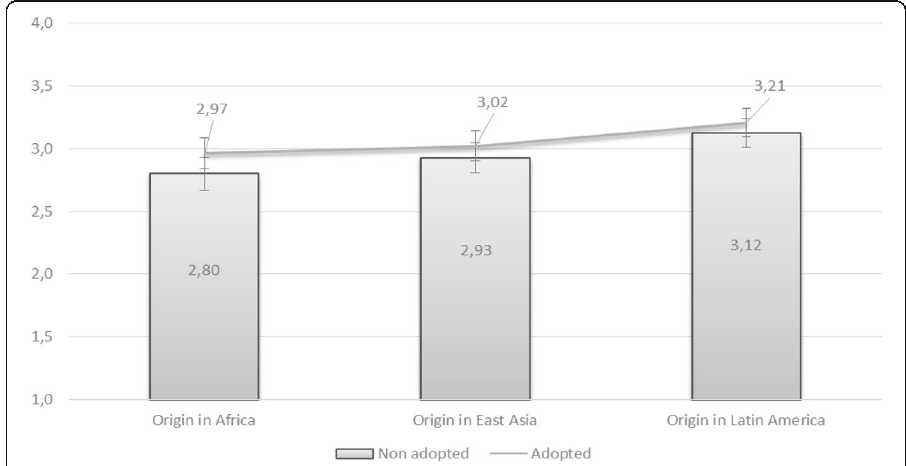
Fig. 2 Attitudes towards interracial marriage: Comparison of white Swedish respondents ’ attitudes towards non-white migrants and transnational adoptees in